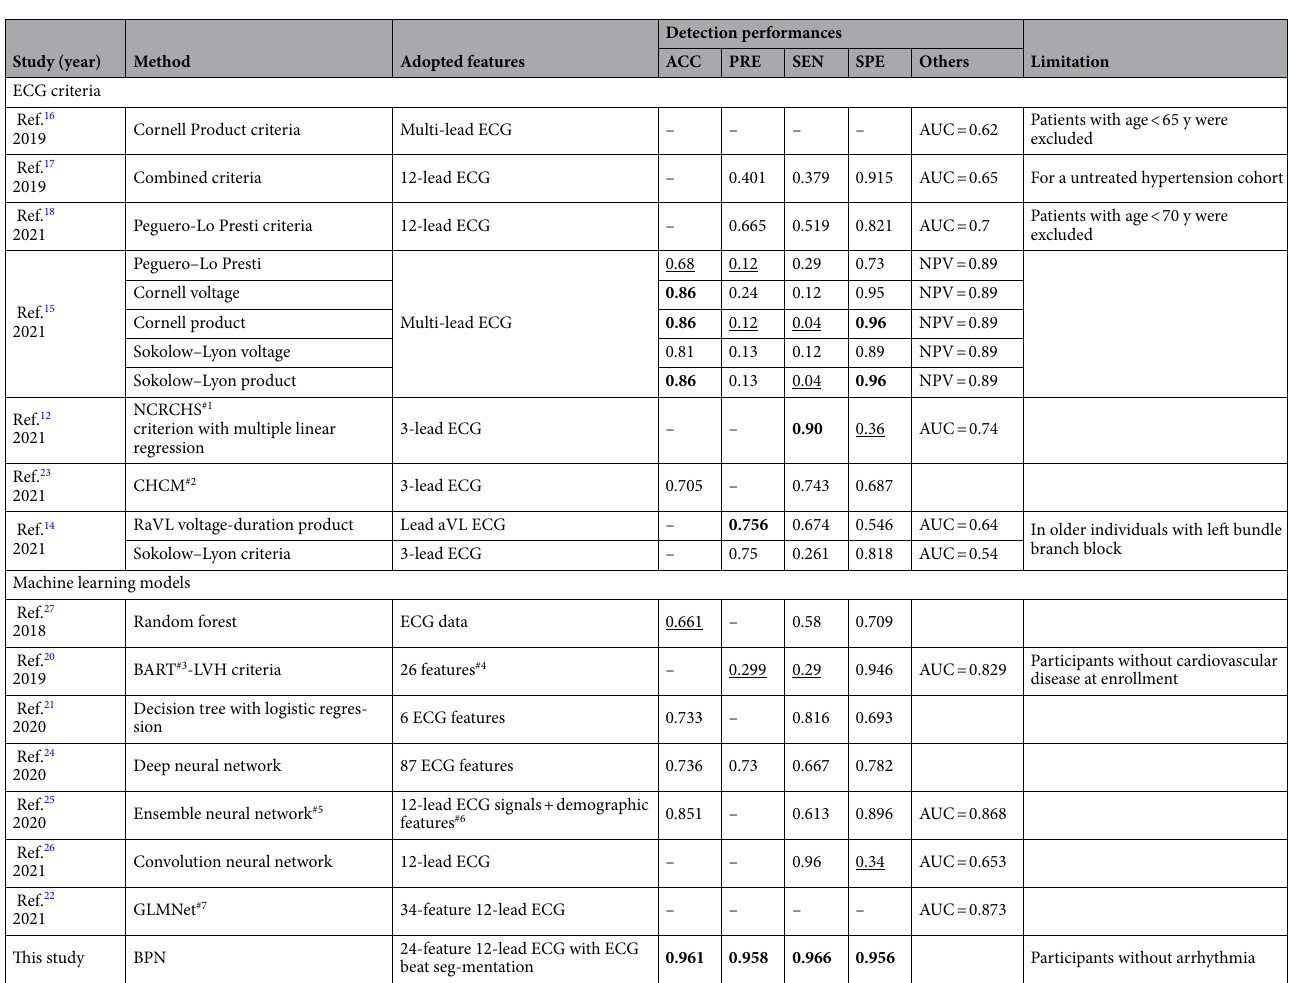
Table 6. Comparison of state-of-the-art methods for detecting LVH using ECG. ACC Accuracy, PRE Precision, SEN Sensitivity, SPE Specificity, AUC area under ROC curve, NVP negative predictive